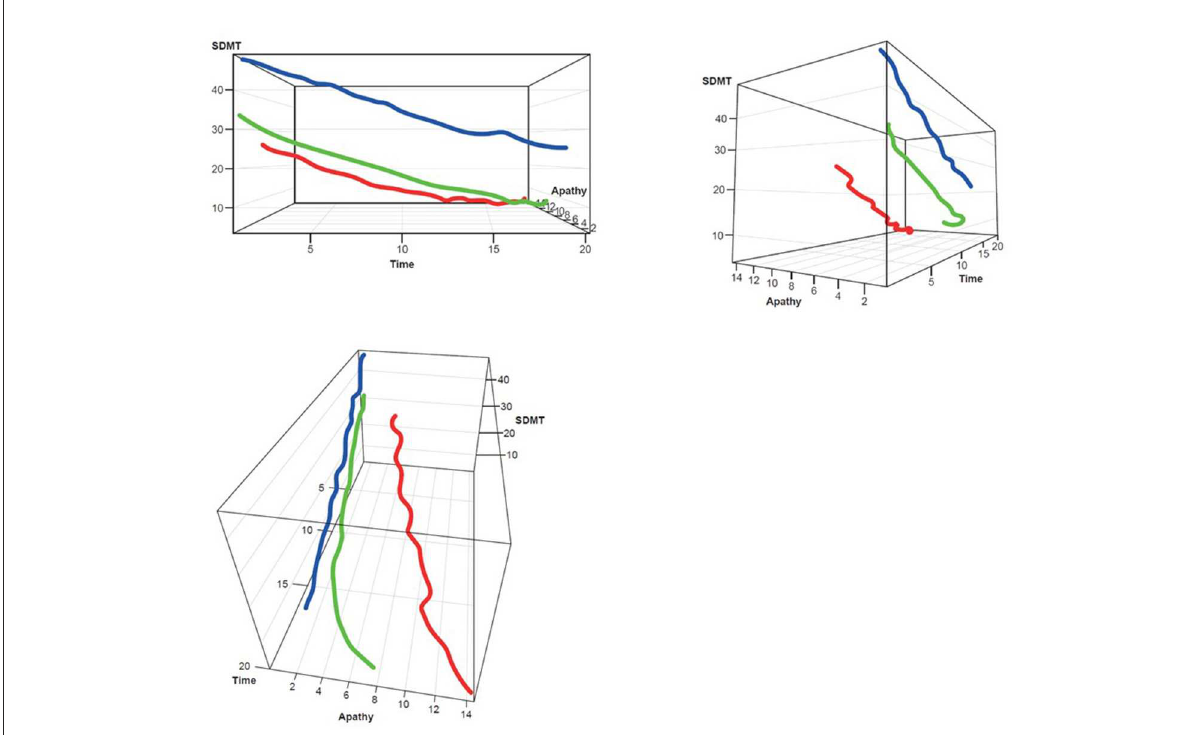
FIGURE5 SDMT–Apathy 3D plot for clustering. Red , rapid progressors; Green , moderate progressors; Blue , slow progressors; SDMT, Symbol Digit Modalities